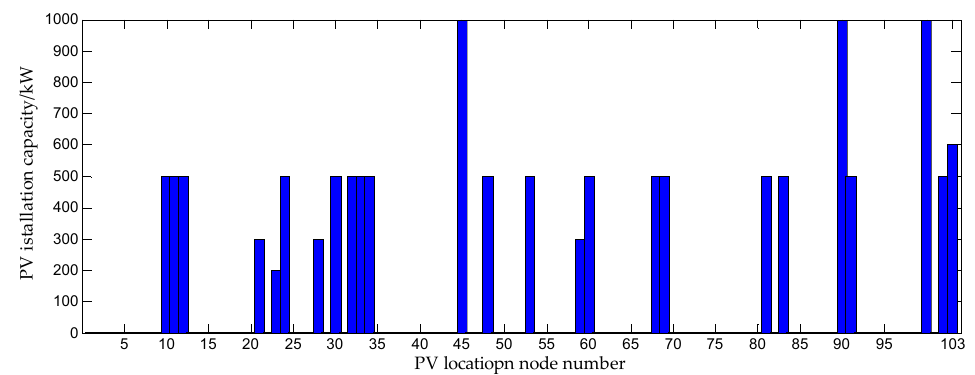
Figure 3. Topology of the radial ADN under study.